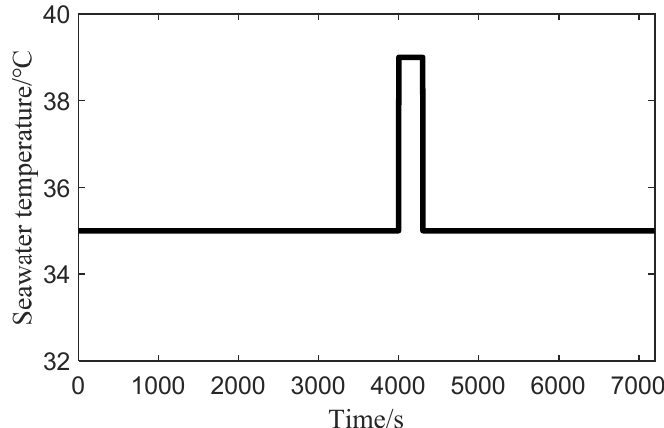
Figure 12. Disturbance of T sea increase.